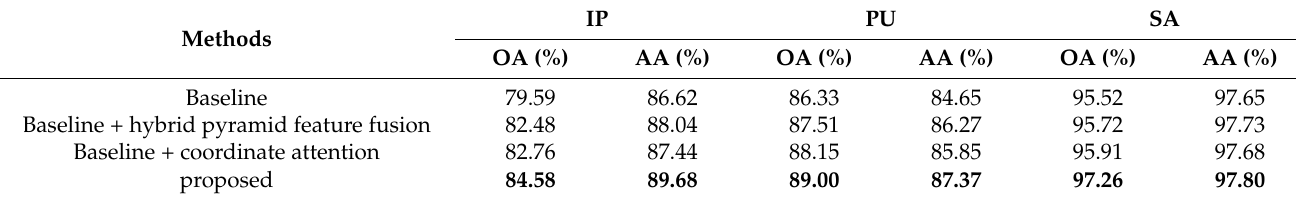
Table 6. Results of ablation